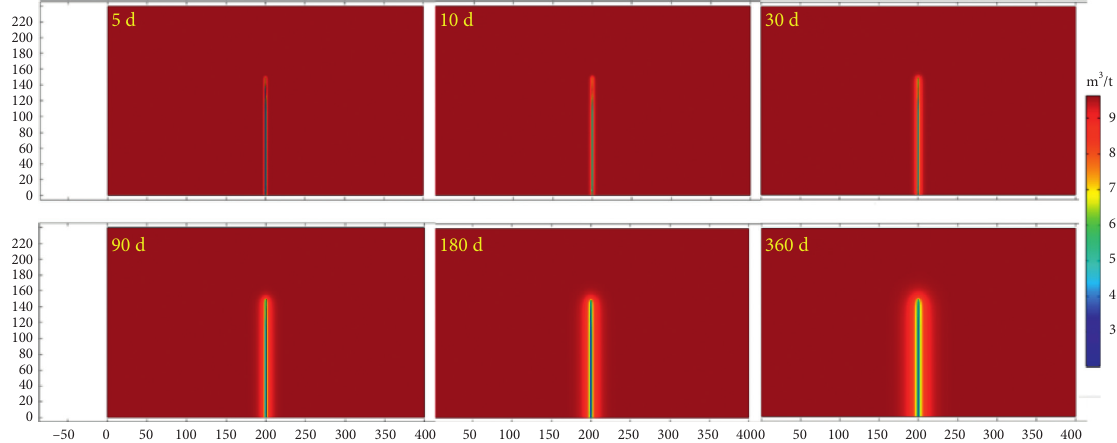
Figure 13: Cloud map of coal seam gas content under different drainage time of 150-meter